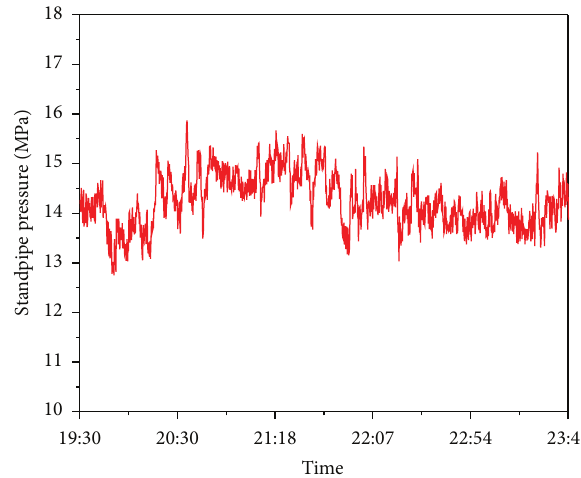
Figure 6: Data acquisition—standpipe pressure data versus time